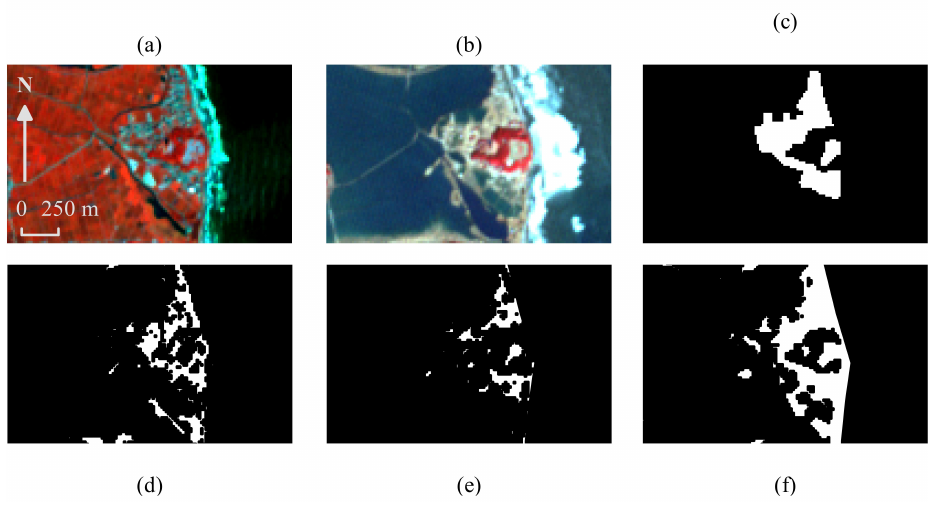
Figure 10. Clustering results, destroyed constructions. ( a ) image taken on 7 July 2010, ( b ) image taken on 19 March 2011, ( c ) ground truth, ( d ) K-Means on subtracted image, ( e ) K-Means on concatenated encoded images, ( f ) DEC on concatenated encoded